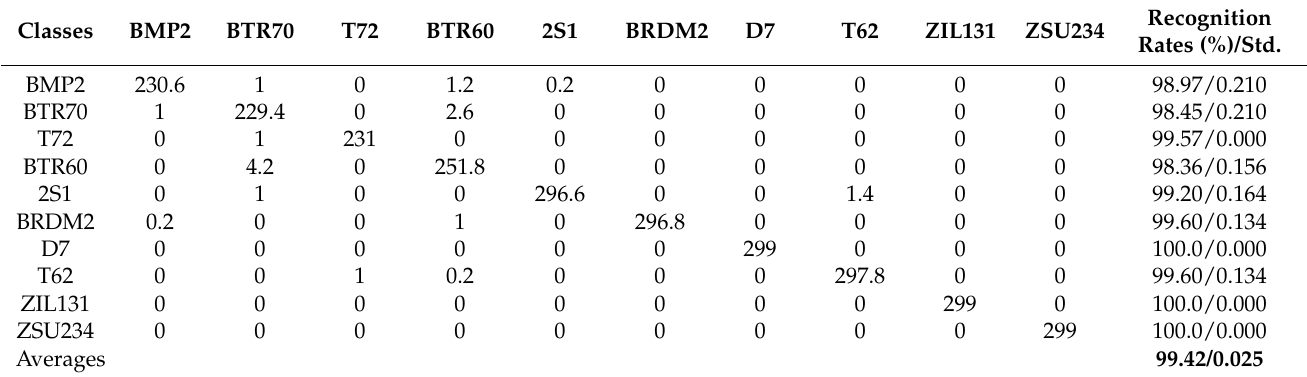
tested by five pre-trained 17, GAN